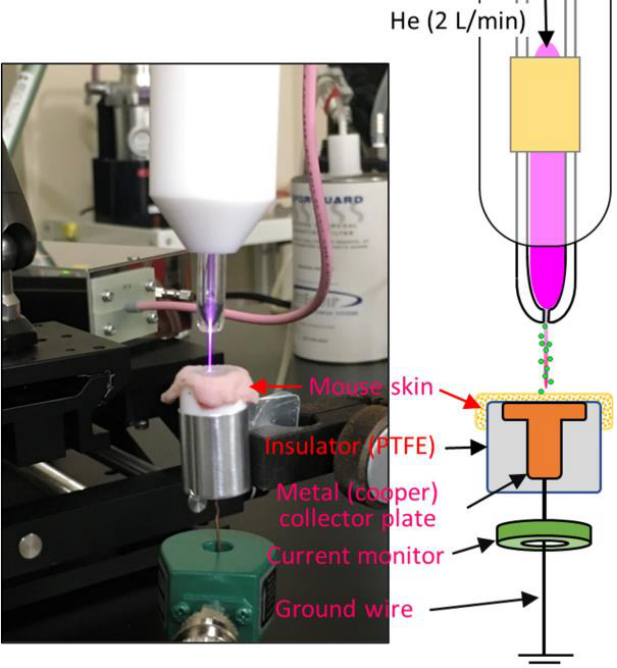
Figure 6. Photograph and schematic of the experimental set-up to measure the current produced through mouse skin by the plasma bullets.